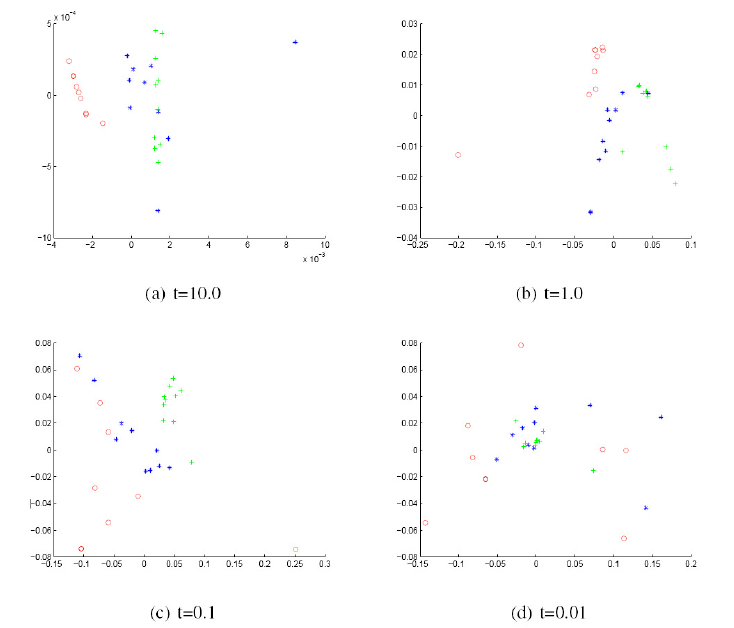
Figure 5. MDS embedding obtained using MHD for the houses data represented by the Gaussian curvature associated with the geodesic triangles. The x and y axes are the embedding coordinates corresponding to the leading two dimensions of the MDS embedding. The differently-coloured symbols denote different object classes.